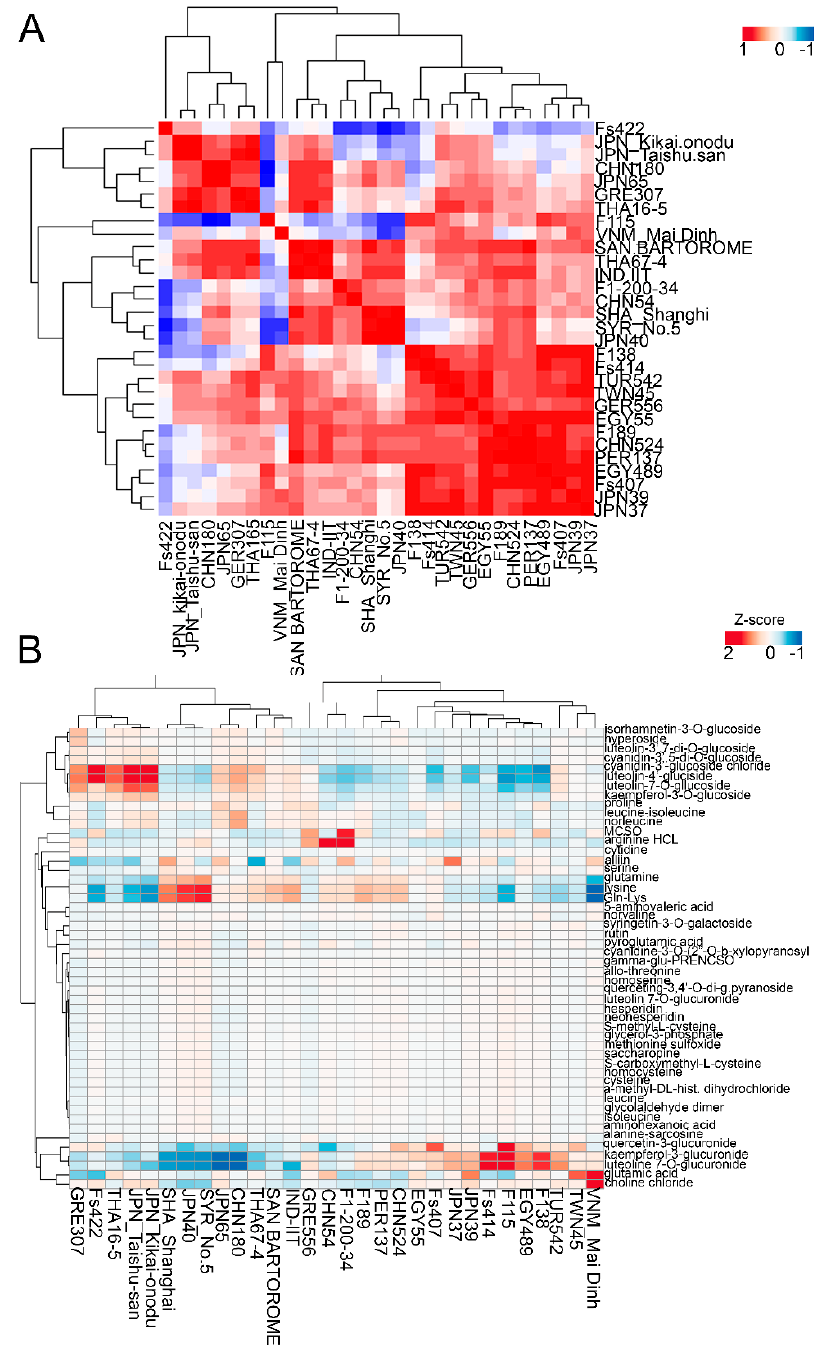
Figure 3. Correlation analysis and heatmap clustering of the 30 garlic accessions: ( A ) Pearson correlation analysis and ( B ) heatmap clustering of the normalized metabolite matrix.